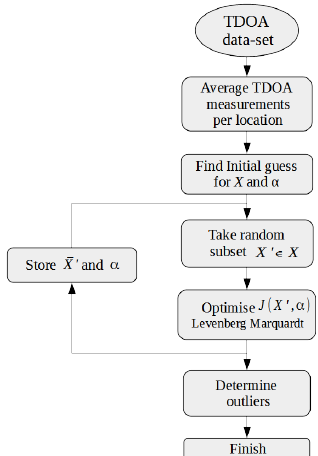
Figure 2. ( a ) Normal distribution of TDOA measurement errors; ( b ) Distributions of the subset TDOA measurement errors. The mean value of each sub-distribution is denoted by × .